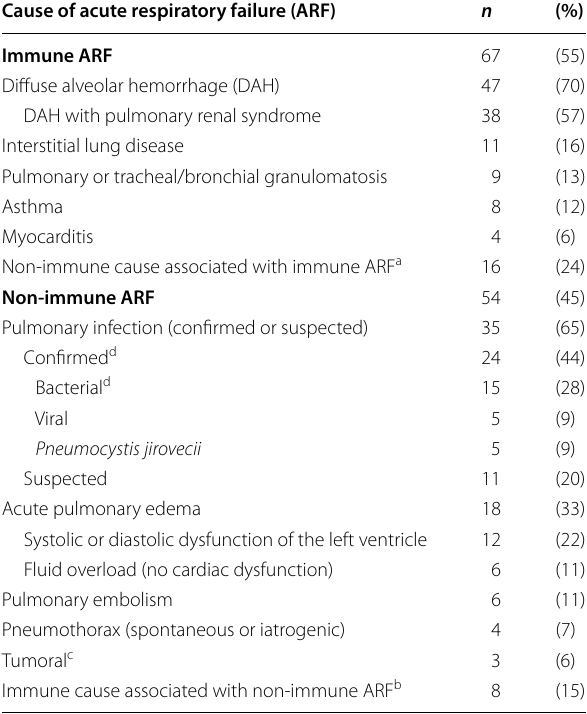
Table 1 Causes of acute respiratory failure associated with